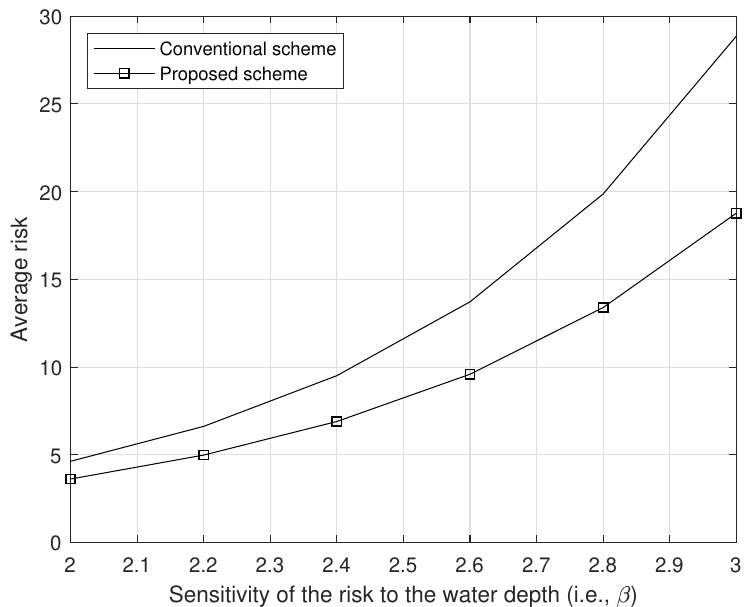
Figure 10. The average risk with respect to the sensitivity of the risk to the water depth (i.e., β